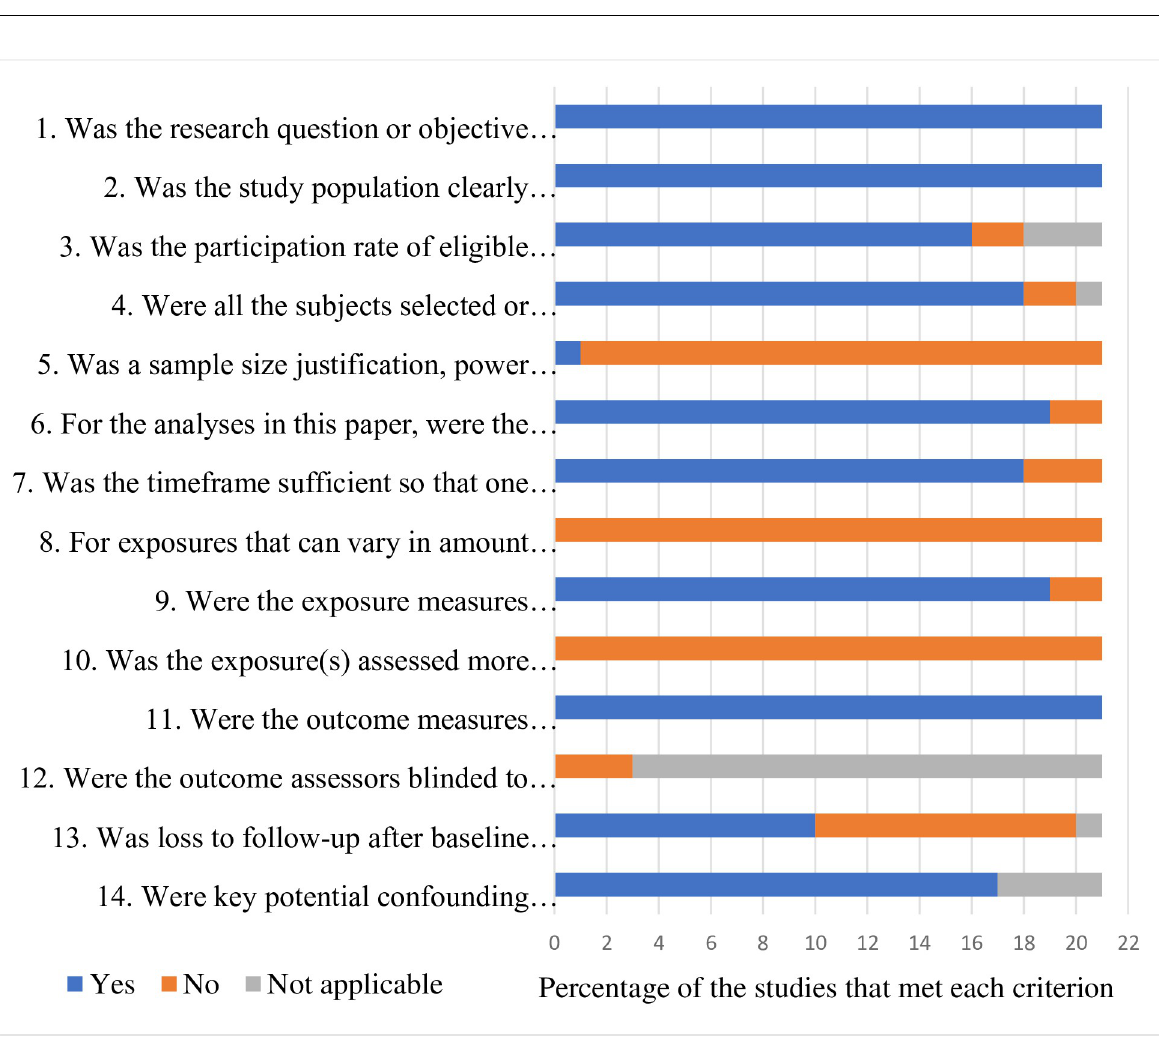
Fig 2. Quality assessment of the